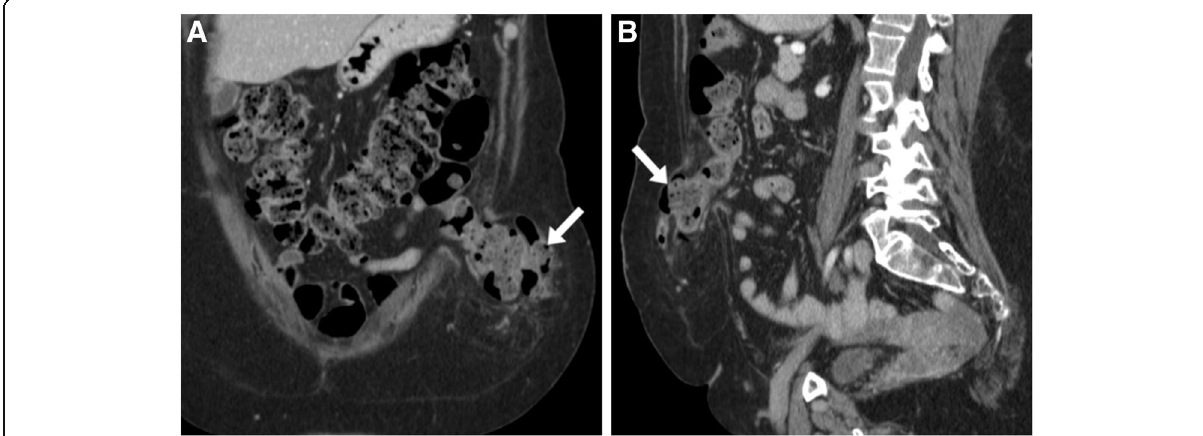
Fig. 13 Elongated, patent permanent descending colostomy (arrows) containing feces in a patient with history of abdomino-perineal resection, without formation of hernia sac, consistent with type 0